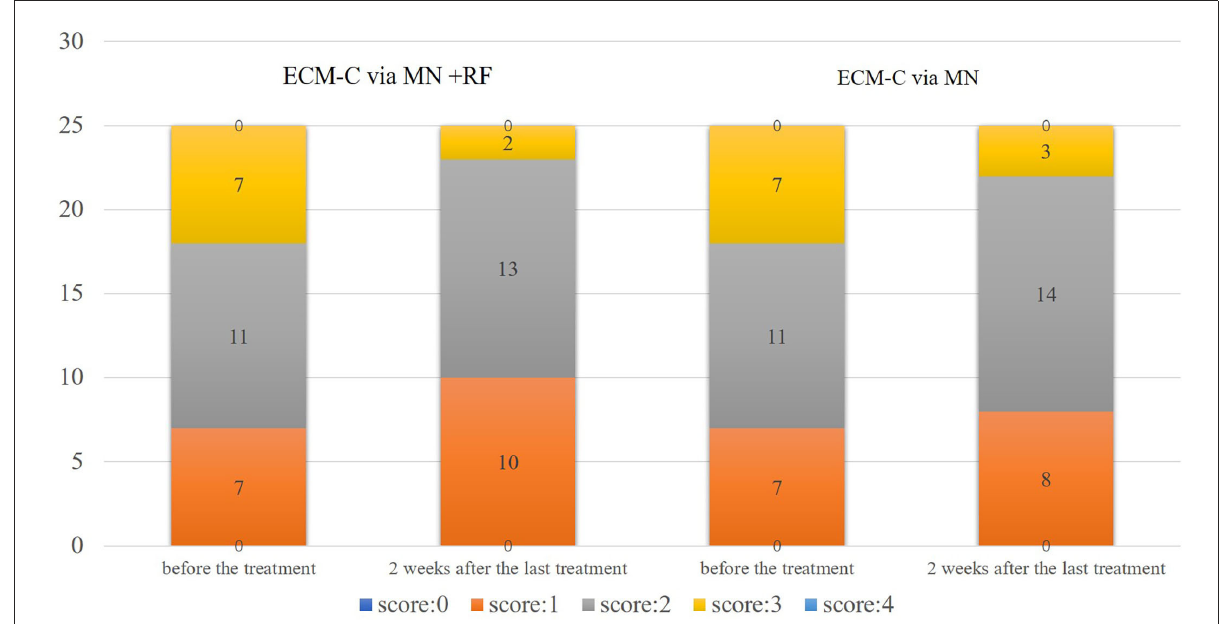
FIGURE7 CFGS assessment graph presentation by doctor. CSGF, Crow’s Feet Grading Scale; 0 = no wrinkles, 1 = very fine wrinkles, 2 = fine wrinkles, 3 = moderate wrinkles, 4 = severe